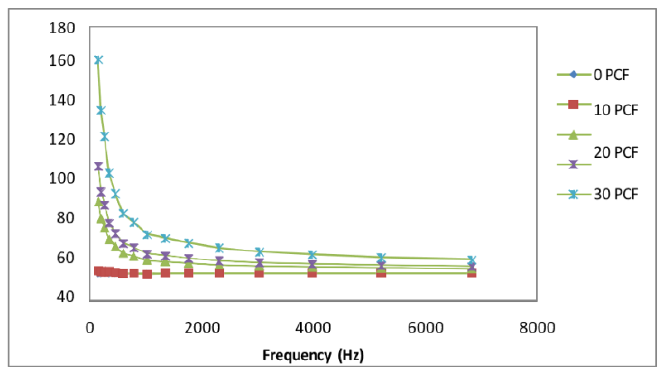
Figure 9. Variation in dielectric constant of PTH-coated fiber/PE composites with frequency.